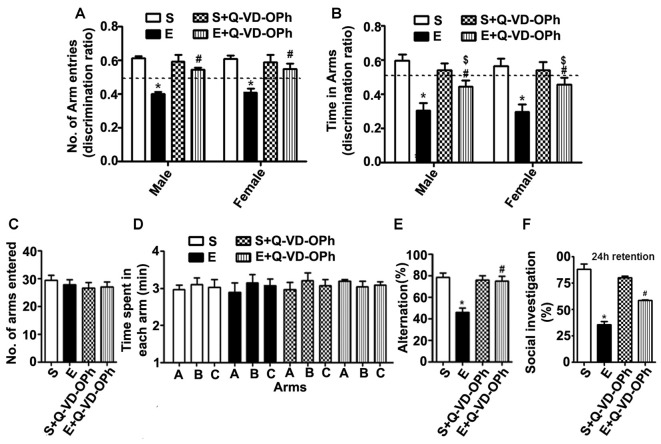
Administration of a caspase-3 inhibitor before ethanol treatment in P7 mice rescues persistent spatial and social recognition memory (SRM) deficits in adulthood. (A,B) The spatial working memory was determined using the Y-maze in adult mice treated with saline (S), ethanol (E), S + Q-VD-OPh, or E + Q-VD-OPh at P7. The discrimination ratio [preference for the novel arm over the familiar other arm (Novel/Novel + Other)] for arms entries (A) and dwell time (time spent in each arm) (B) of S, E, S + Q-VD-OPh and E + Q-VD-OPh -treated mice, 24 h after the first encounter with the partially opened maze. The dashed line denotes chance performance (0.5). (C–E) The spontaneous alternation memory of adult mice treated with saline (S), ethanol (E), S + Q-VD-OPh, or E + Q-VD-OPh at P7 was evaluated using the Y-maze. (C) The number of arm entries by mice in all the treatment groups. (D) The time spent in each arm by mice in all the treatment groups. (E) The spontaneous alternation performance by mice in all the treatment groups. (F) The percent of social investigation is shown for P7 S, E, S + Q-VD-OPh and E + Q-VD-OPh -treated adult mice, 24 h after the first encounter with the same juvenile mice. (*p < 0.01 vs. saline; $p < 0.05 vs. saline; #p < 0.05 vs. ethanol, n = 8 mice/group). Error bars, SEM (two-way ANOVA with Bonferroni’s post hoc test).